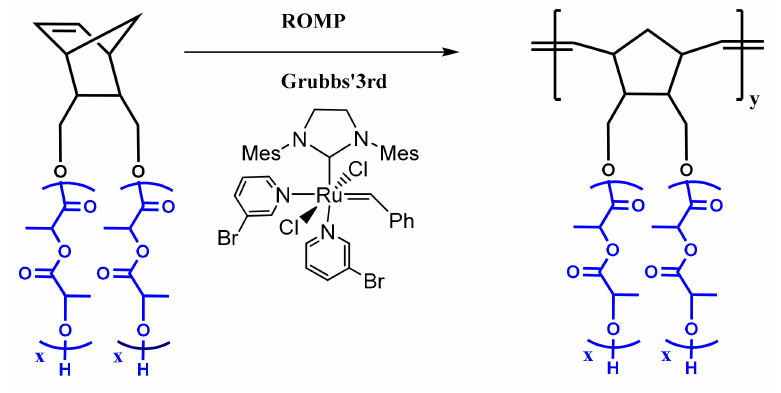
Figure 3. Synthesis of